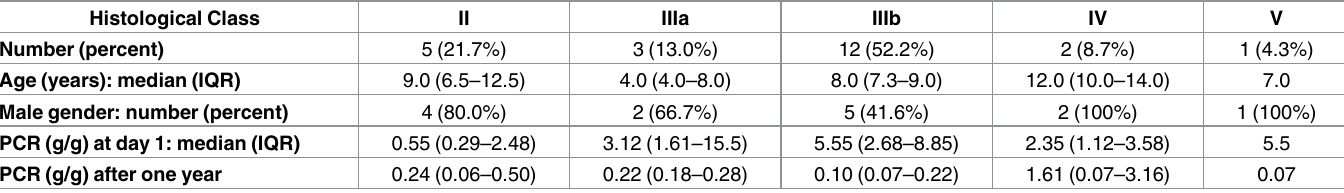
Table 2. Histological class from renal